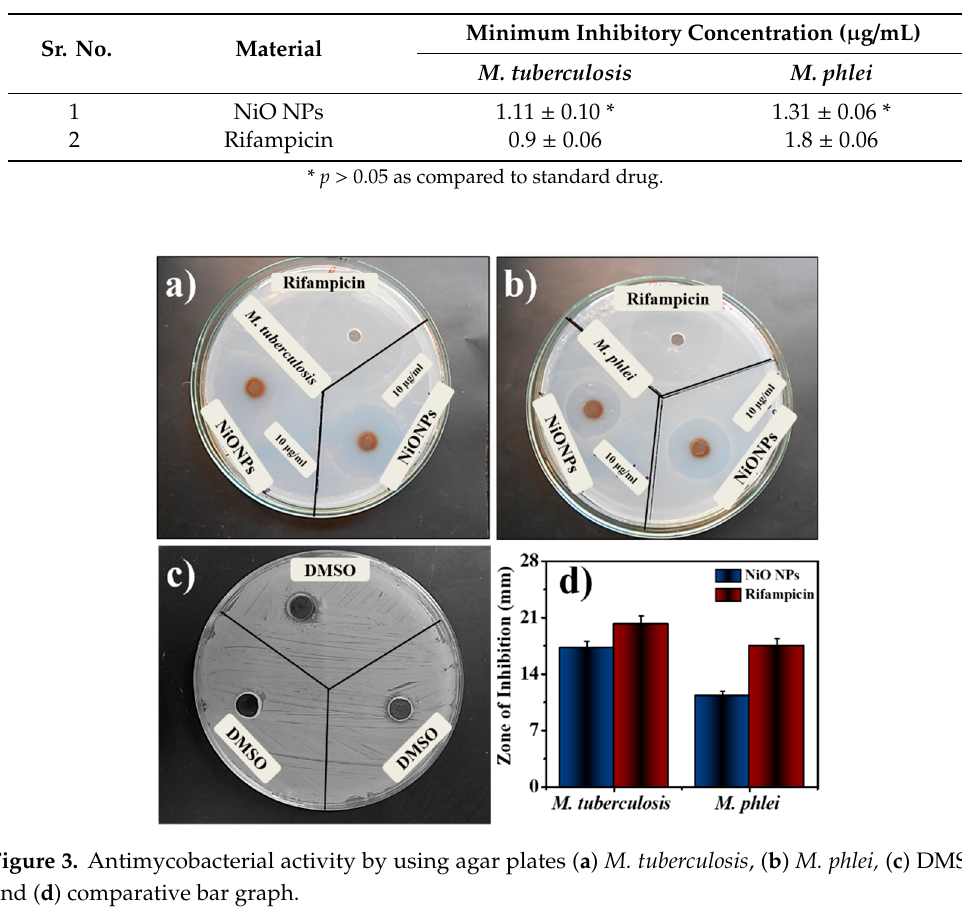
Figure 4. Hemolytic activity of NiO NPs as compared to Rifampicin (Mean ± SD; n = 3). 3.5. Antioxidant Activity The antioxidant activity of as-synthesized NiO NPs was obtained by the DPPH method and the results were compared with the standard (ascorbic acid). DPPH method works on the principle of